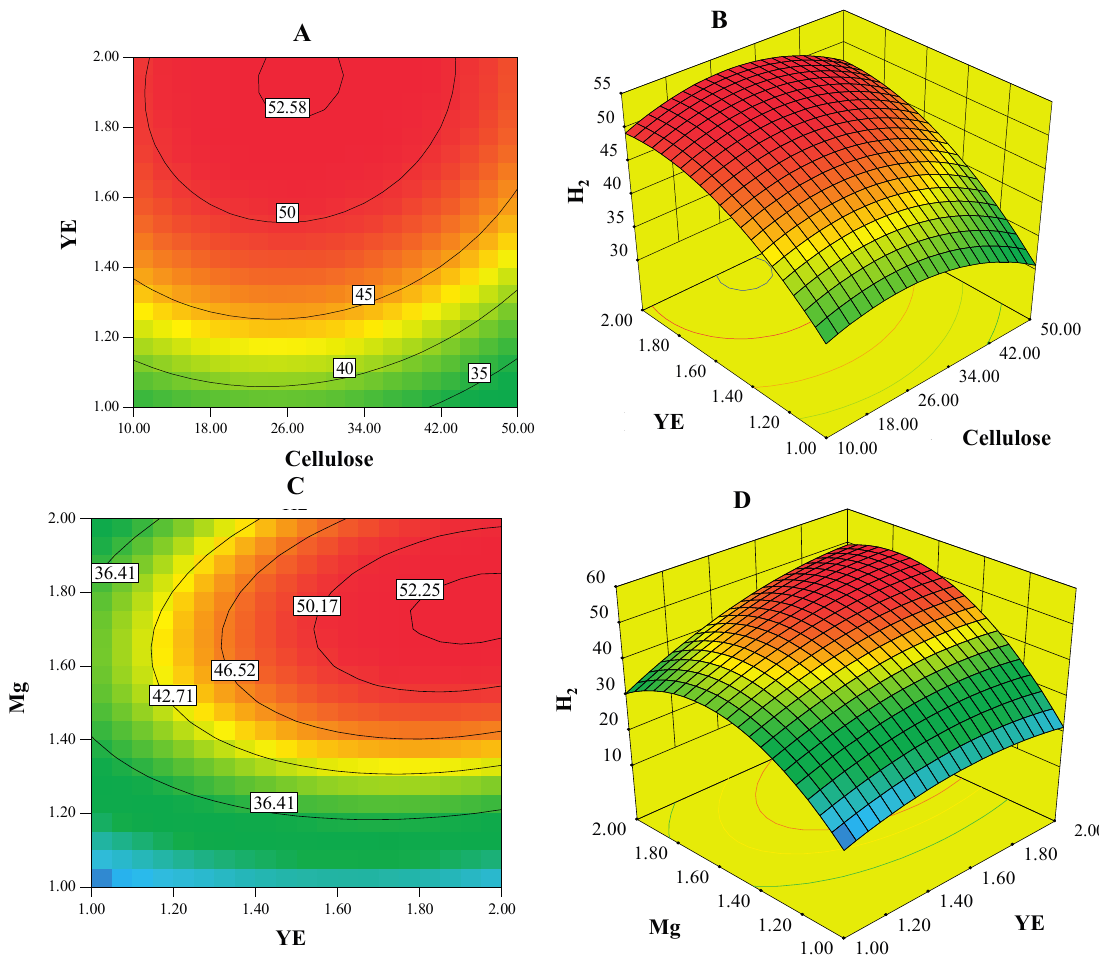
Figure 2. Contour and surface plots of H 2 -concentration (mmol/L) model show interactions between predictor variables. ( A , B ) show the interactions between yeast extract (YE) and cellulose while magnesium chloride (Mg) level was held constant, at 1.5 g/L; ( C , D ) show the interactions between Mg and YE while cellulose level was held constant, at 30